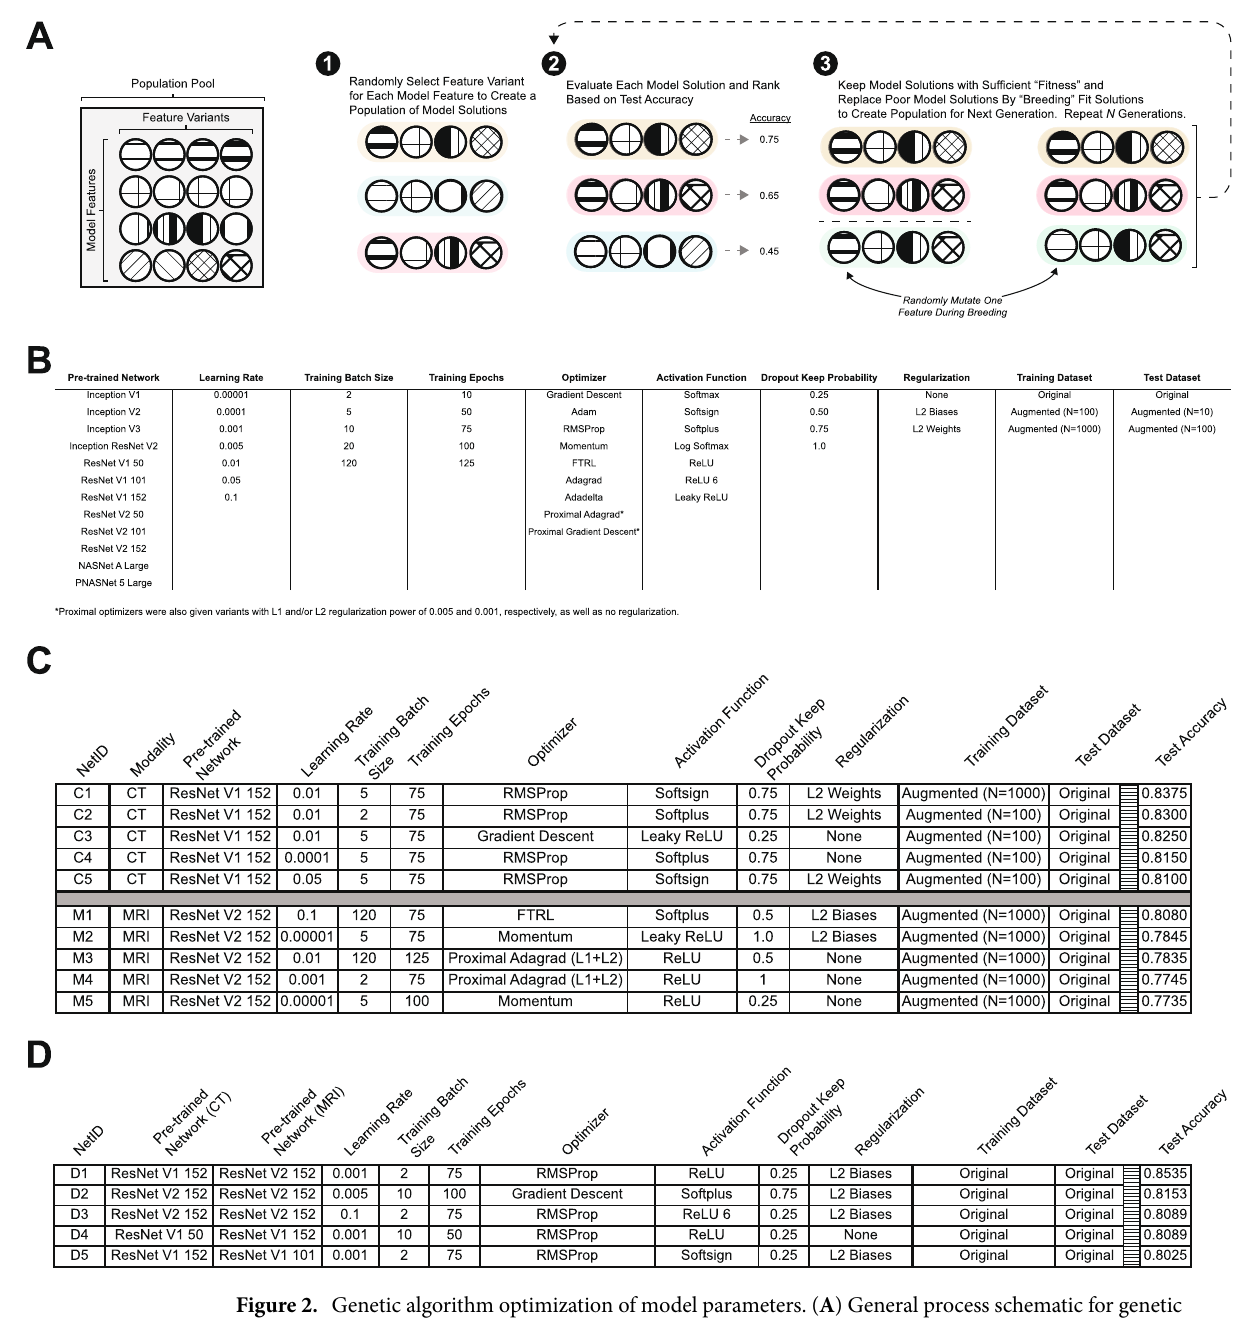
Figure 2. Genetic algorithm optimization of model parameters. ( A ) General process schematic for genetic algorithm parameter optimization. Moving from left to right, a feature variant is selected for each model feature to create individual networks (Step 1; individuals are highlighted in unique colors). Individuals are trained and evaluated to determine fitness and ranked accordingly (Step 2). Two networks are chosen from the fittest population and a new network is derived by selecting from feature variants in these two networks, and variants are occasionally mutated (i.e., randomly selected from the population pool; Step 3). ( B ) Model feature and respective feature variants explored in first phase of genetic algorithm optimization. Each column represents a model feature to be optimized and each row is a possible feature variant for the GA to select from. This table reflects the “Population Pool” ( A ). ( C ) Top-5 performing networks for independent CT and MRI networks after 10 generations of 100 solution populations; ranked according to test accuracy. ( D ) Top-5 performing networks for combined CT-MRI networks after 10 generations of 100 solution populations; ranked according to test